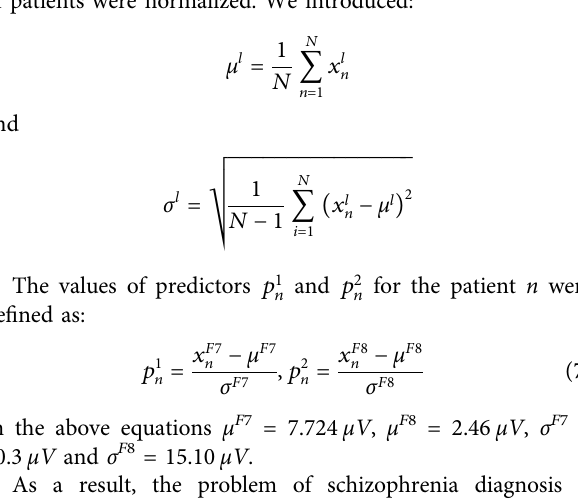
Frontiers in Chemistry |